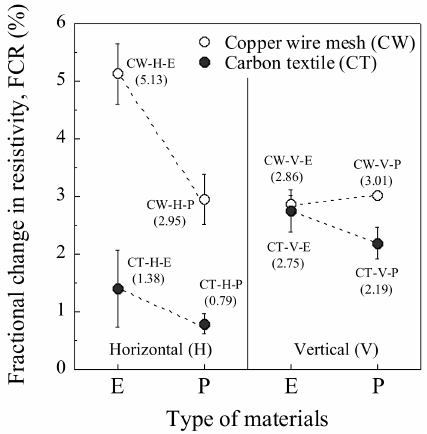
Figure 15. Effects of connector on FCR of SCAs under 60 MPa compressive